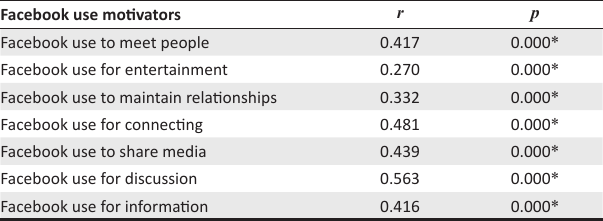
TABLE 3: Pearson product–moment correlations ( r ) and significance probabilities ( p ) for relations of motivators and Facebook use. Facebook use motivators